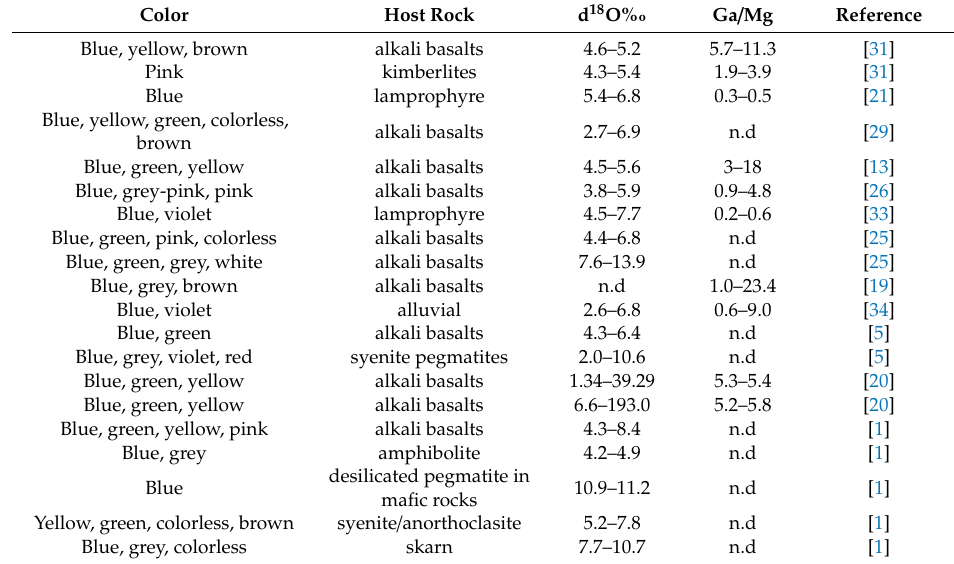
Summary of worldwide oxygen isotope ranges and Ga / Mg for some sapphires (n.d = not